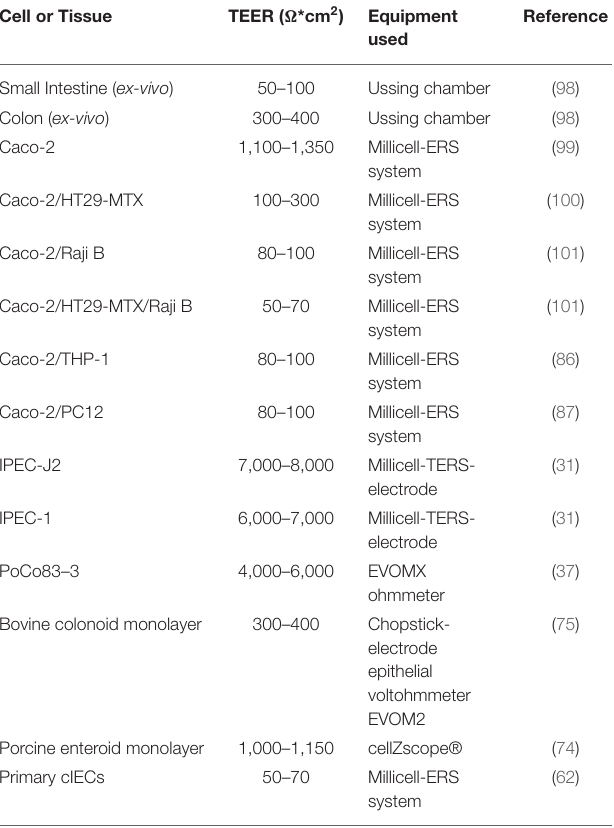
TABLE 2 | TEER values for different cell lines, cocultures, and intestinal tracts. Cell or